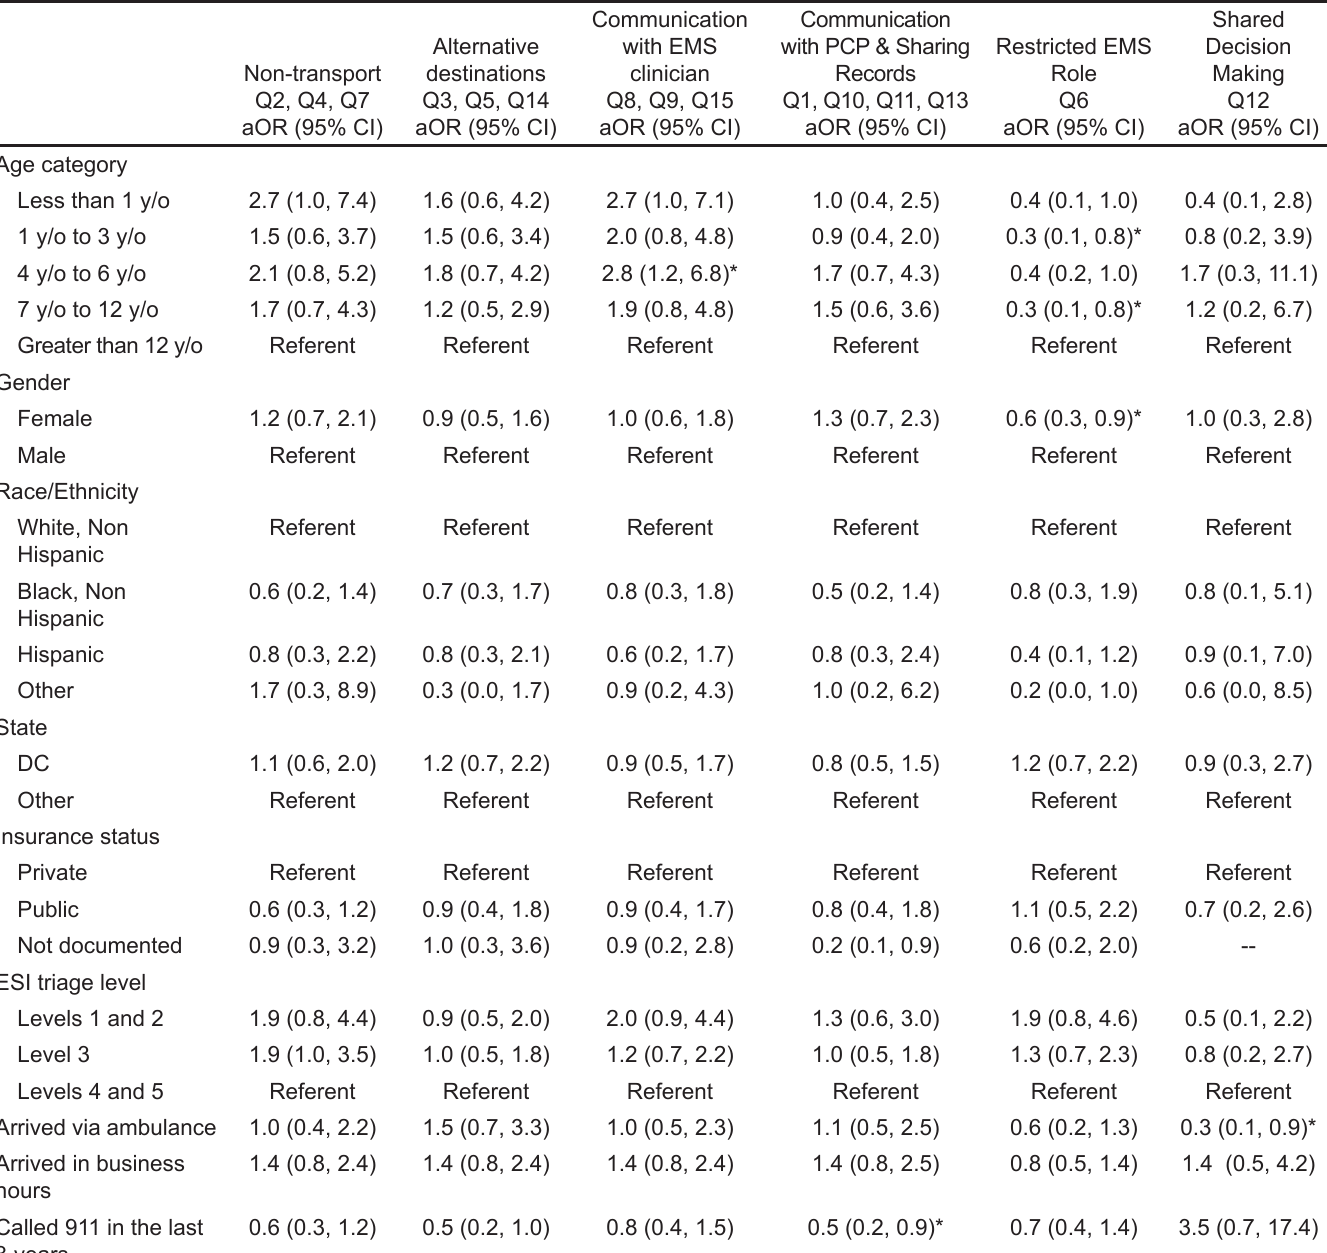
Table 3. Factors associated with agreement to all survey items within a